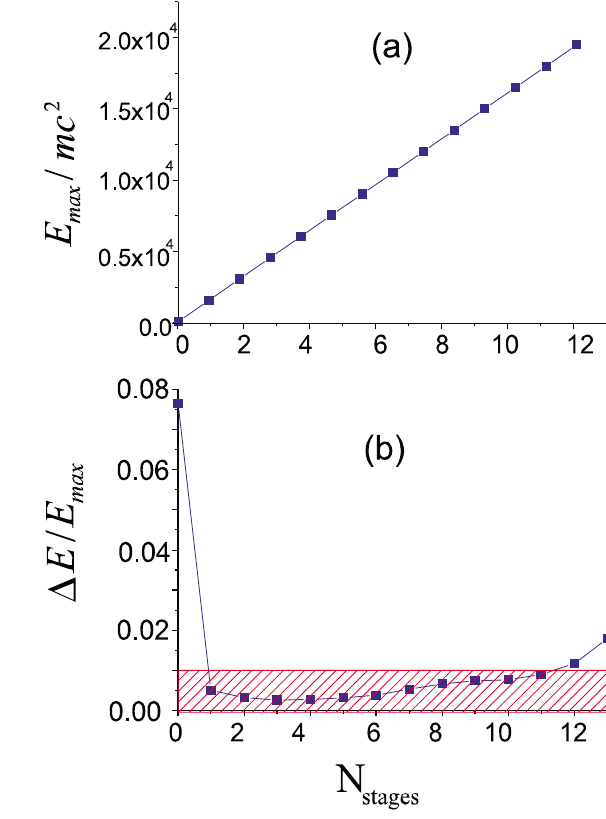
FIG. 8. (Color) Multistage LWFA with prebuncher; initial electron bunch parameters (before bunching stage) are L b 0 (cid:1) (cid:1) 50 m m, ´ (cid:1) 0.6 mm 30 m m (100 fs), R 0 0 a n